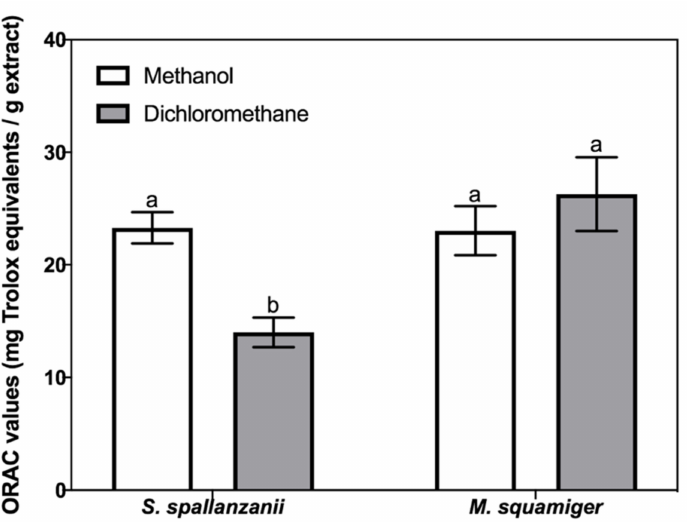
Figure 4. Antioxidant activity (mg trolox equivalents TE/g) determined by the oxygen radical ab- sorbance capacity (ORAC) assays in dichloromethane and methanol extracts of Sabella spallanzanii and Microcosmus squamiger. For the same species, collumns labelled with different letters re significantly different ( p <